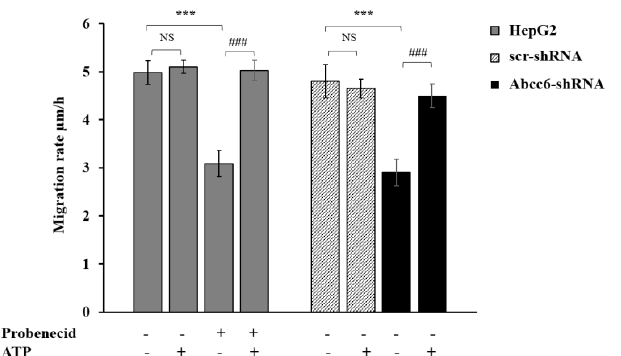
Figure 7. Effect of probenecid and ABCC6 silencing on the migration rate of HepG2 cells. Cells were treated with 250 µM probenecid for 48 h (gray plain bars, Probenecid+). DMSO-treated cells were used as the control (gray plain bars, Probenecid-). A total of 500 µM ATP was added to either the control cells (gray plain bars, Probenecid-, ATP+) or to probenecid-treated cells (gray plain bars, Probenecid+, ATP+). HepG2 cells were transduced with scrambled shRNA (grey-texturized bars, scr-shRNA) or with specific ABCC6-shRNA (black bars, ABCC6-shRNA). A sample of 500 µM ATP was added to either control cells (grey-texturized bars, scr-shRNA, ATP+) or to ABCC6 silenced cells (black bars, ABCC6-shRNA, ATP+). Data are expressed as mean ± standard error (SE) of three replicates from three independent experiments and were analyzed by one-way ANOVA followed by Dunnett’s post hoc: *** p < 0.001 probenecid-treated cells vs. control cells in the absence of ATP and ABCC6-shRNA vs. scr-shRNA in the absence of ATP; ### p < 0.001 probenecid + ATP-treated cells vs. probenecid-treated cells and ABCC6-shRNA cells + ATP vs. ABCC6-shRNA cells without ATP. NS, not significant [32].